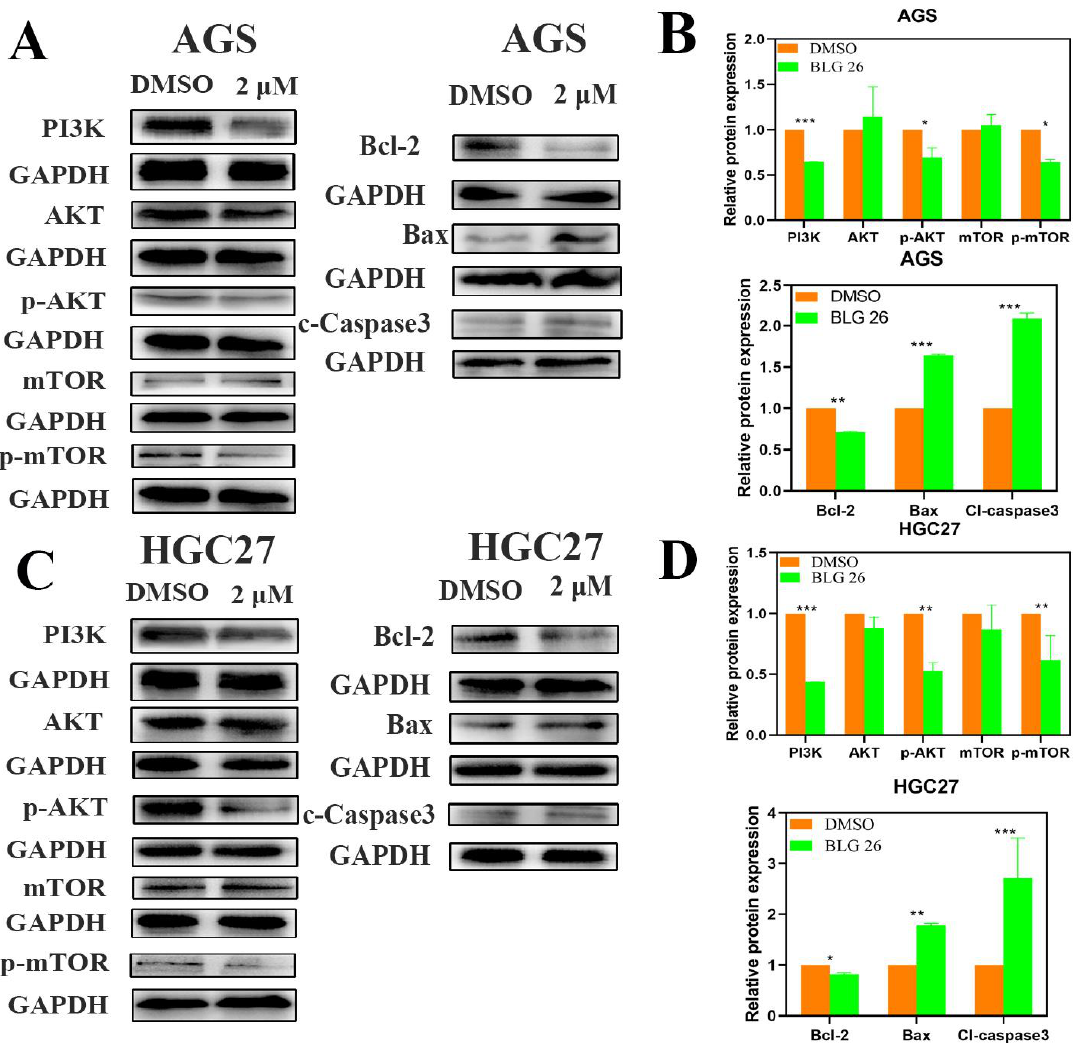
Figure 6. The effect of BLG26 and the expression of mitochondrial-dependent pathway-related proteins and PI3K/AKT/mTOR-signal pathway-related proteins. ( A , C ) protein levels of PI3K, AKT, p-AKT, mTOR, p-mTOR, Bcl-2, Bax, and cleaved caspase 3. ( B , D ) Statistical analysis. * p < 0.05, ** p < 0.01, *** p < 0.001 compared with control.